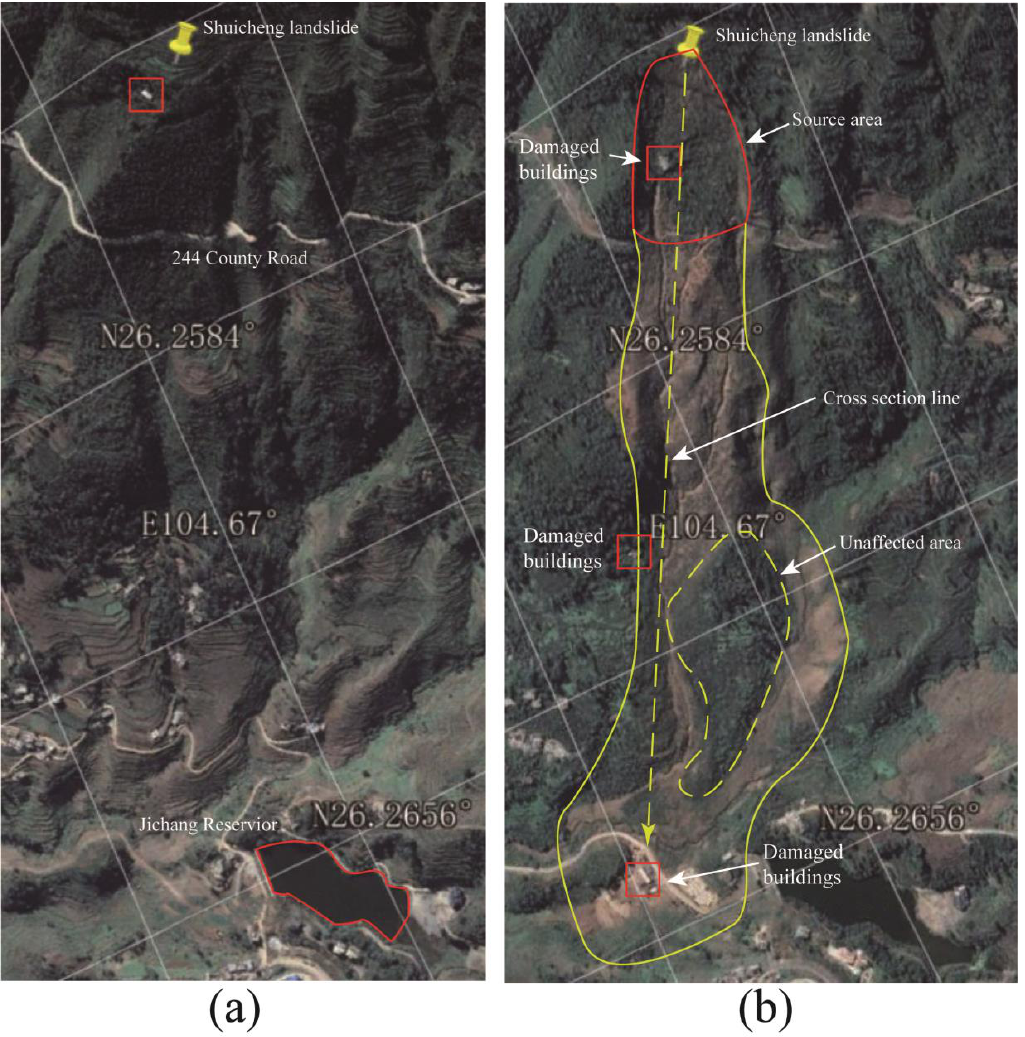
Figure 4. Comparison of pre-sliding satellite image from Google Earth in 2018 ( a ) and post-sliding satellite image from Google Earth in 2020 ( b ). The landslide area is circled in a yellow solid line. Red boxes mark residential